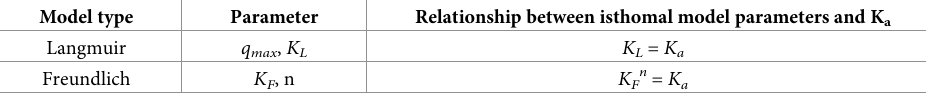
Table 1. Relationship between isothermal model parameters and equilibrium